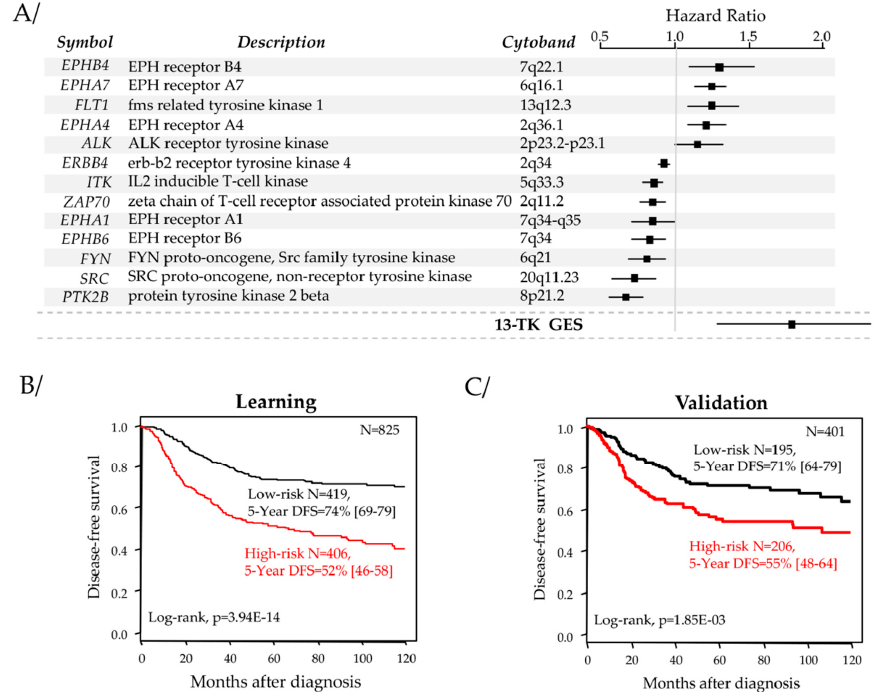
Figure 2. 13-Gene signature and its prognostic value for DFS. ( A ) List of the 13 genes retained after Akaike information criterion (AIC) stepwise regression analysis with Forest plots of hazard ratio (HR) for DFS for each gene and the 13-TK gene expression signatures (GES). ( B , C ) Kaplan–Meier DFS curves of patients according to the 13-gene classifier in the learning set ( B ) and the validation set ( C ).